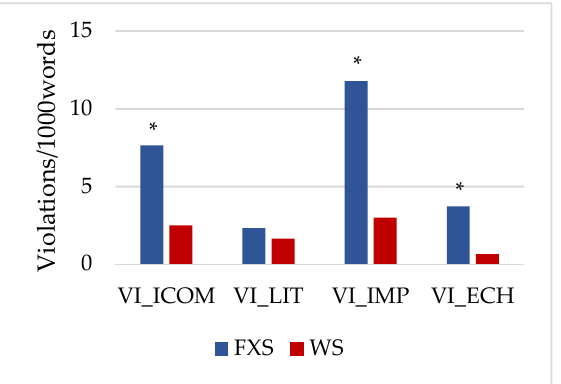
Figure 2. Violation indexes (VIs) of conversational response. Note: ICOM = incomprehension; LIT = literality; IMP = impulsivity; ECH = echolalia, * = p < 0.05.